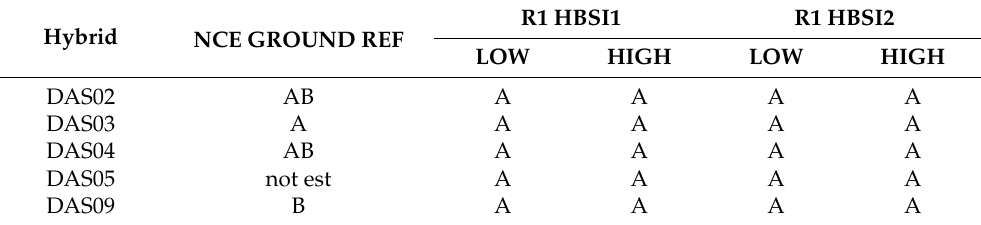
Table 10. NCE hybrid rankings at ACRE for HSI of interest at low and high spatial resolution. Hybrid rankings are based on a Tukey–Kramer HSD hybrid means comparison; hybrids with the same letter are not significantly